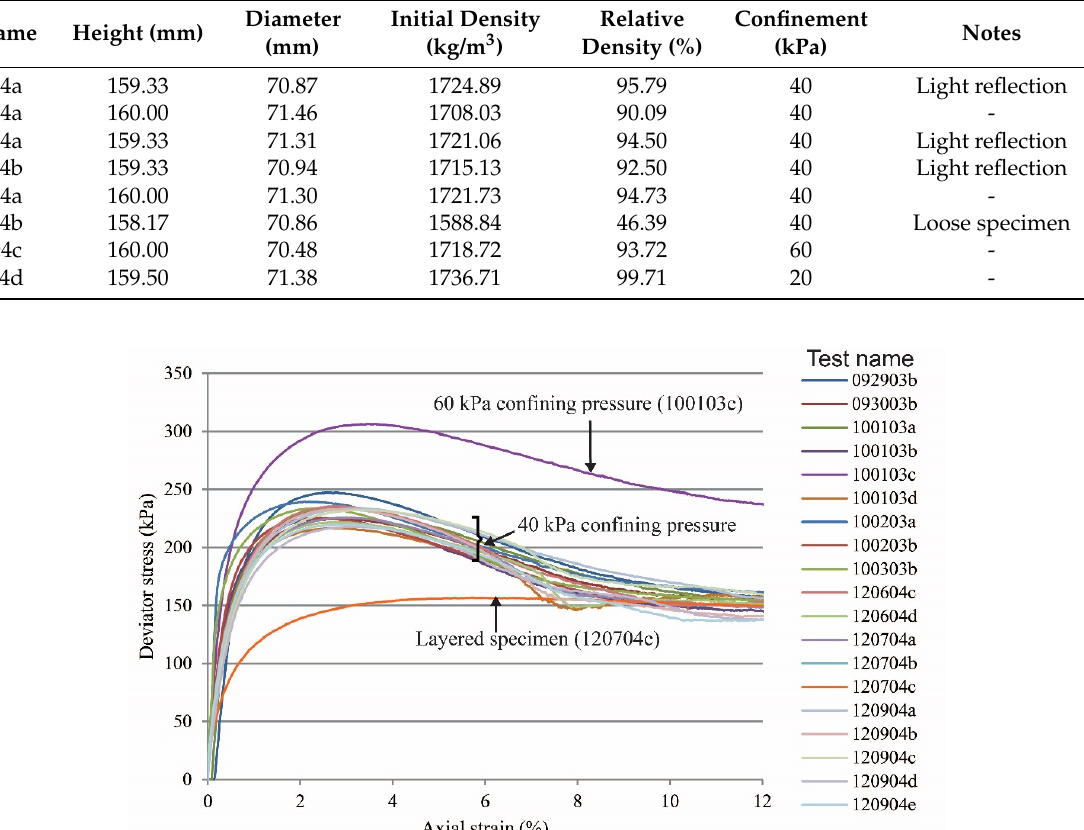
Table 2. Experimental characteristics of single-layer sand specimens prepared by dry pluviation (homogeneous specimens).